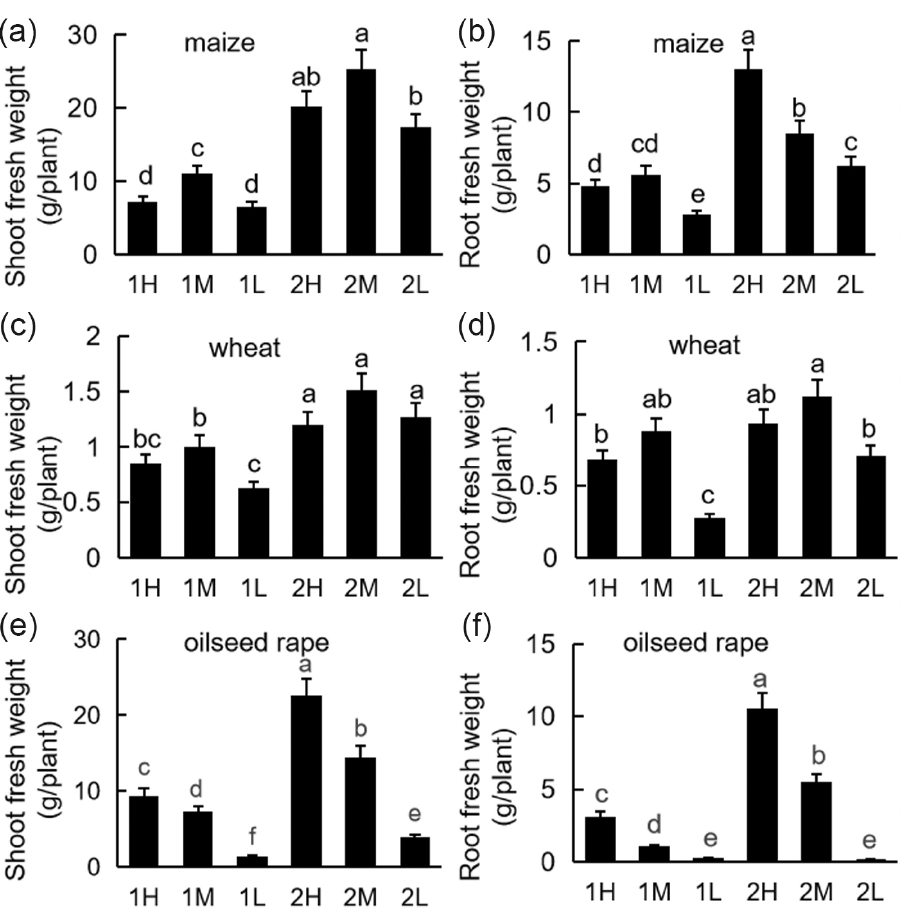
Figure 1. Fresh weight of plants under different light conditions: 20-day-old seedlings were subjected to one week of relatively high-light treatment (1H), one week of medium-light treatment (1M), one week of relatively low-light treatment (1L), two weeks of relatively high-light treatment (2H), two weeks of medium-light treatment (2M), or two weeks of relatively low-light treatment (2L). Shoot biomass of maize ( a ), wheat ( c ), and oilseed rape ( e ) seedlings. Root biomass of maize ( b ), wheat ( d ), and oilseed rape ( f ) seedlings. Bars represent standard deviations of 3 independent replicates (3 seedlings per replicate). Values followed by different letters are significantly different at p < 0.05 according to Duncan’s multiple range test. Table 1. The photosynthetic parameters of maize seedlings under different light